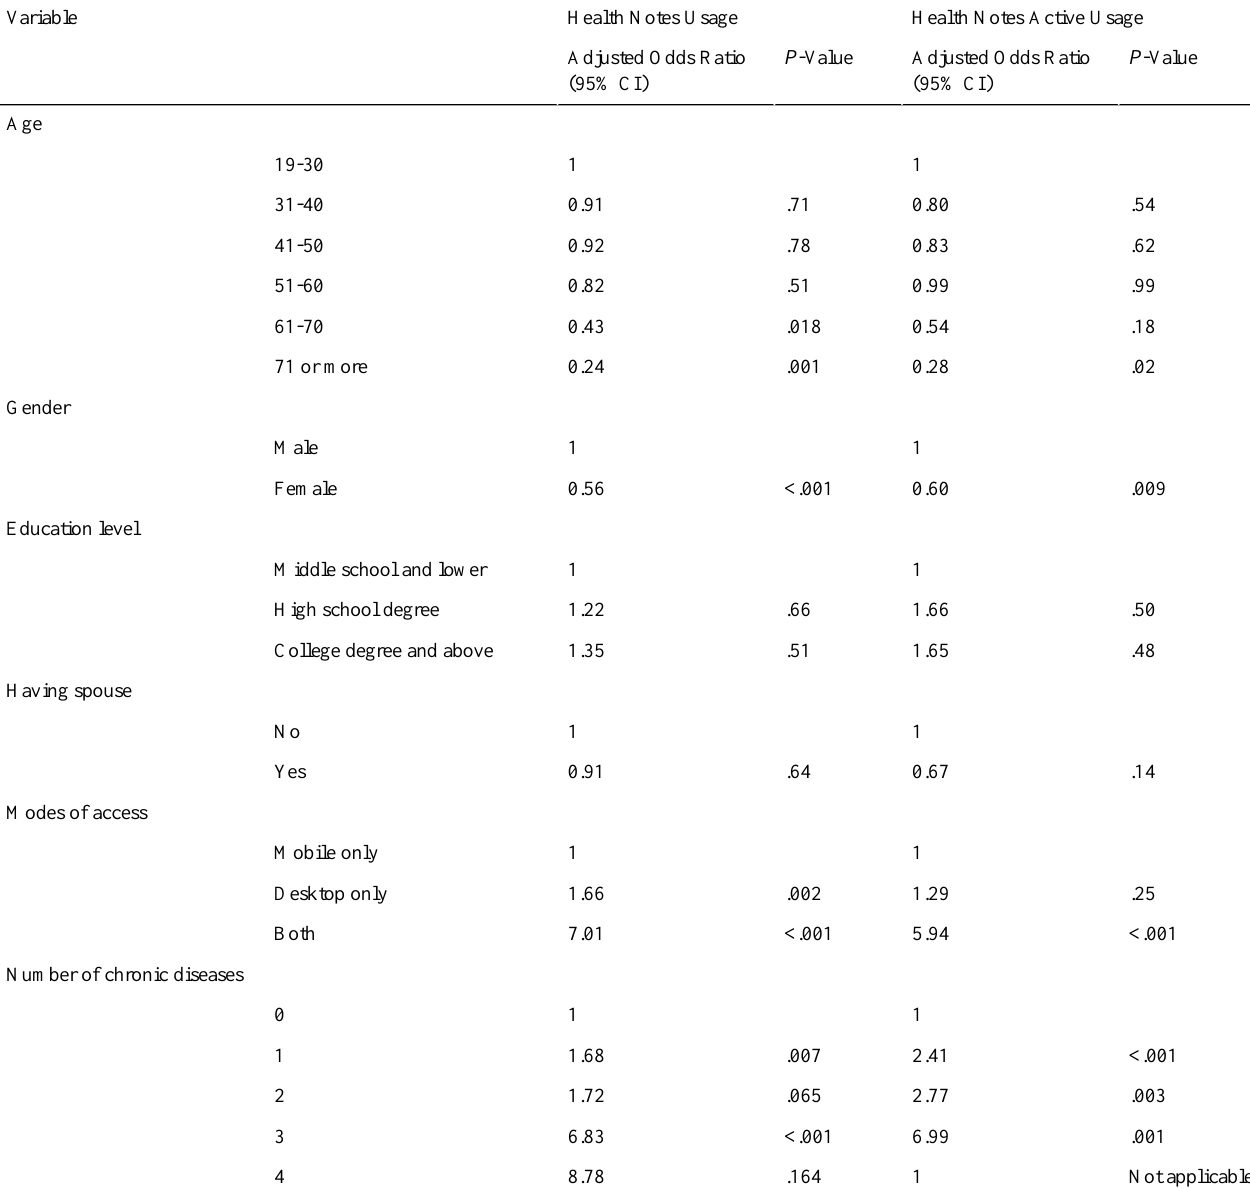
Table 2. Multivariable analysis of the factors associated with completing Health Notes in Health4U (Model